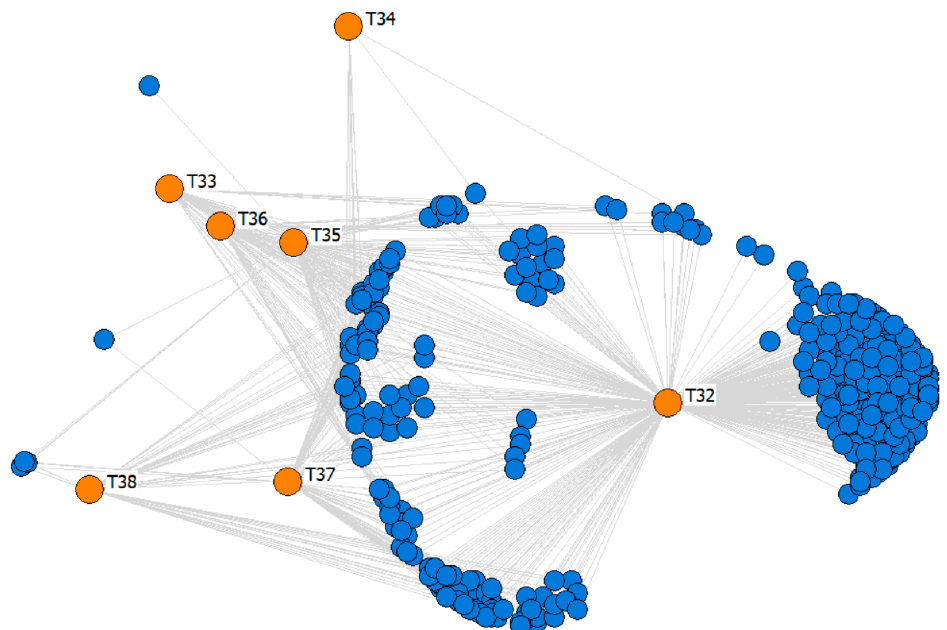
Figure 4. Two-mode network visualization of farmers and technologies. Technologies. T32, breeding soundness evaluation in bulls. T33, semen fertility evaluation. T34, evaluation of female body condition. T35, oestrus detection. T36, pregnancy diagnosis. T37, type of mating. T38, breeding policy. Farmers.